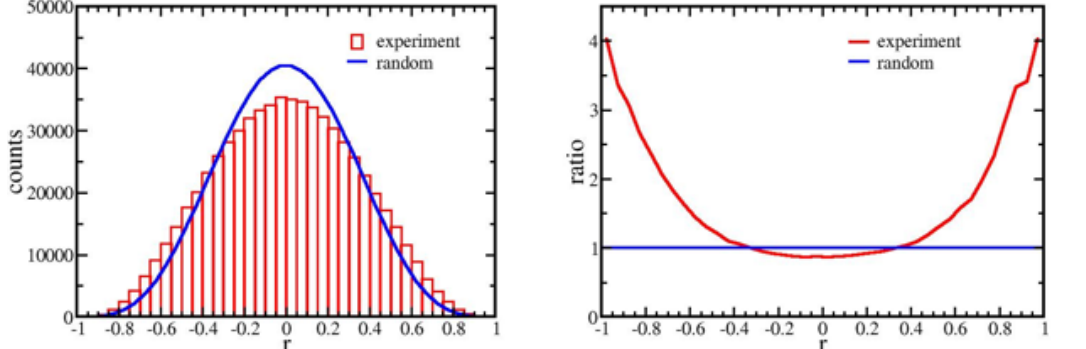
Figure 1. Distribution of correlation coefficients. (A) The histogram consists of 40 bins ranging from 2 1 to 1. (B) The ratio of number of correlation coefficients in the experimental data to the random case for bin in Figureoˆ 1A. At high correlations, the number of microRNA-mRNA pairs is larger than expected in the random case. This result suggests information exists in the correlation coefficients between miRNAs and mRNAs.